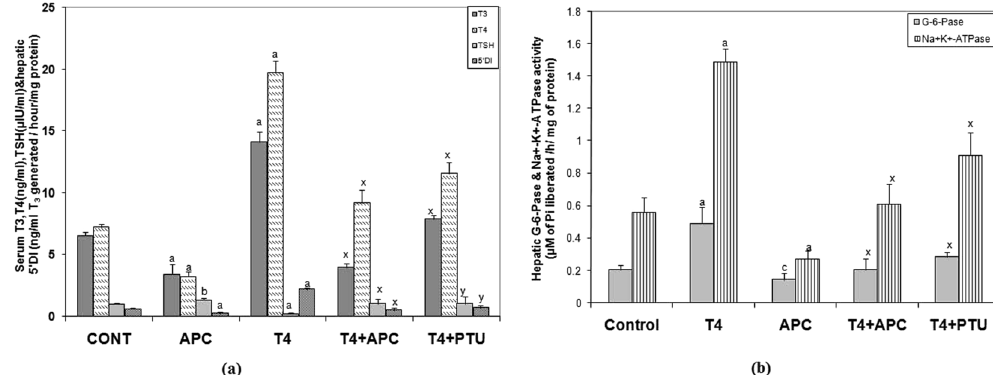
Figure 3. ( a ) Changes in concentrations of serum T 3 (ng/ml), T 4 (ng/ml X10), TSH ( µ IU/ml) and hepatic 5 ′ D1 (ng/ml T 3 generated/hour/mg protein), following the administration APC (2.0 mg/kg/d) alone or T 4 + APC or T 4 + PTU. Each bar represents the mean ± SEM (n = 7). a P < 0.001 and b P < 0.01 as compared to the respective control value; whereas x P < 0.001 and y P < 0.01, as compared to the respective value of L-T 4 treated group. ( b ) Changes in hepatic G-6-Pase ( μ M of Pi liberated/h/mg protein) and Na + -K + -ATPase activity ( μ M of Pi liberated/h/mg of protein) following the administration APC (2.0 mg/kg/d) alone or T 4 + APC or T 4 + PTU in rats. Each vertical bar represents the mean ± SEM. (n = 7). a P < 0.001 as compared to the respective control value, whereas x P < 0.001 as compared to the value of L-T 4 treated animals.